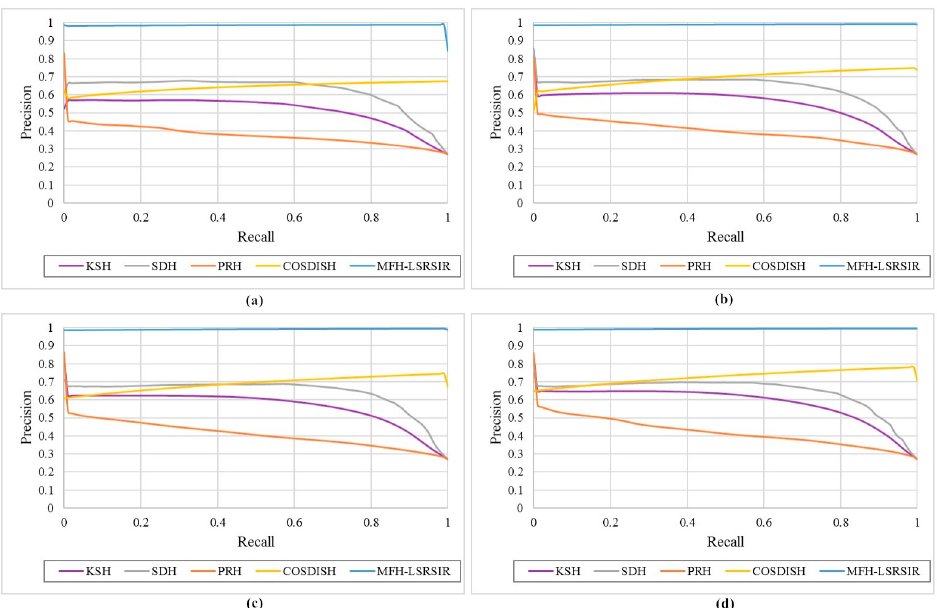
Figure 6. Compared precision-recall curves between different hashing methods with varied hash code lengths on the SAT-4 dataset: ( a ) 8 bits; ( b ) 16 bits; ( c ) 32 bits; and, ( d ) 64 bits.